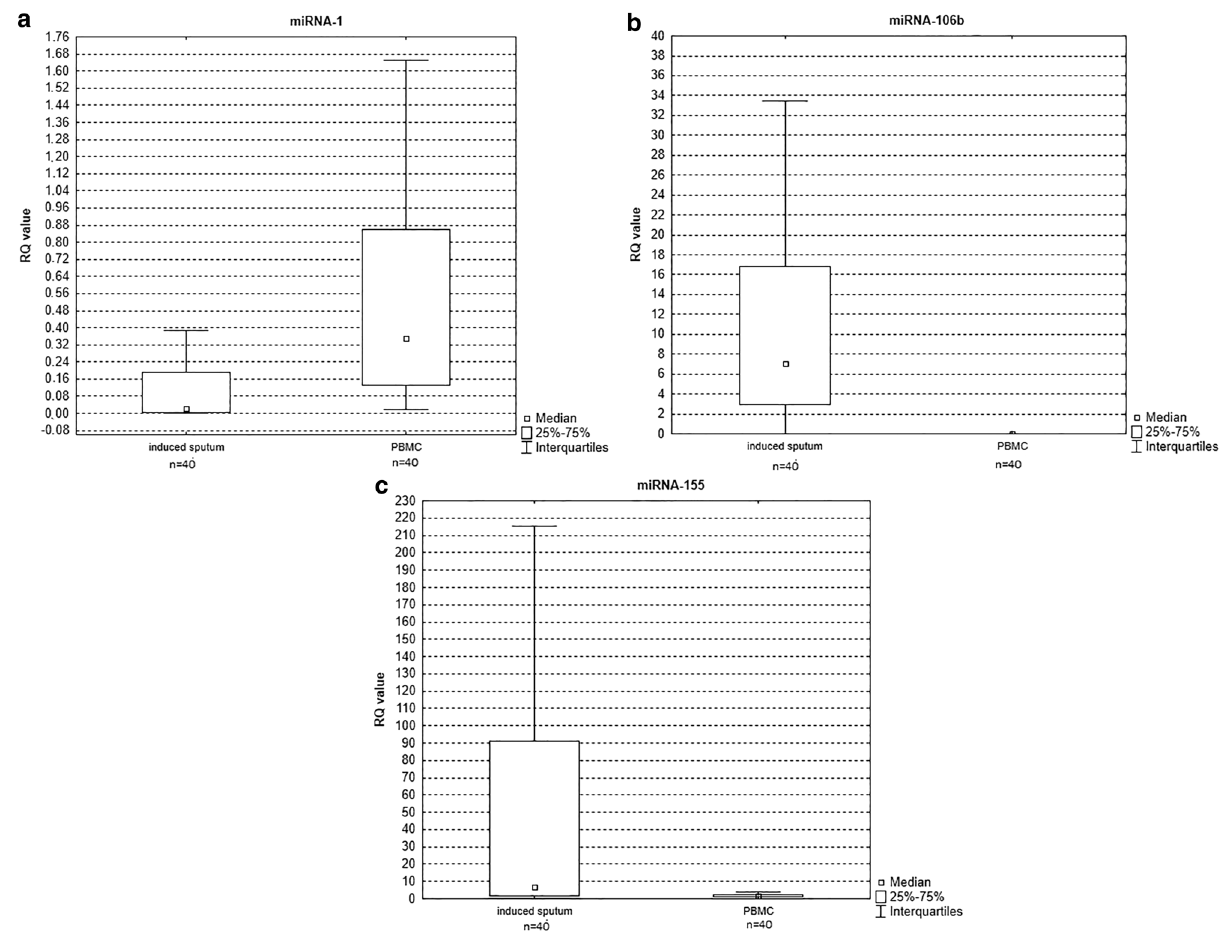
Figure 6. Box-and-whisker plots representing the expression value (median RQ value) of ( a ) miRNA-1 ( p = 0.001) ( b ) miRNA-106b ( p = 0.000069) ( c ) miRNA-155 ( p = 0.000016) in induced sputum versus PB lymphocytes in COPD